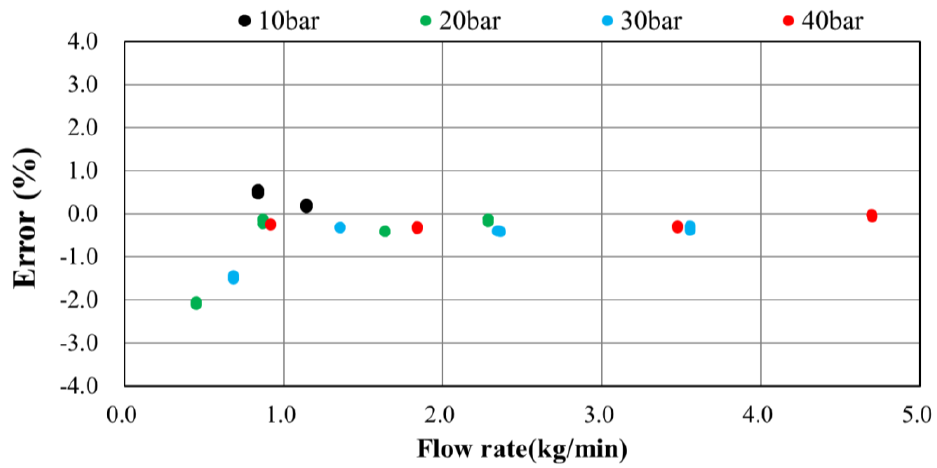
Figure 6. Measurement results of the Coriolis mass flowmeter with different pressure and flowrate conditions.